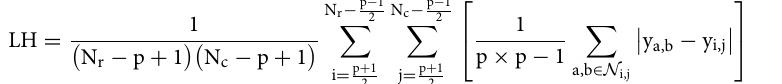
where y i , j is the intensity of the pixel in the i th row and j th column of an image (denoted by Y ), and N i , j is a p × p neighborhood centered around y i , j but not including y i , j . In a p × p neighborhood, the average abso- lute difference between the center pixel and the neighbor pixels is calculated to measure the neighborhood heterogeneity. The LH measure is the mean neighborhood heterogeneity obtained by moving the neighbor- hood window across the whole image. The LH measurements were calculated with multiple neighborhood sizes for both IGTD and REFINED image representations. Two-tail pairwise t-test 27 was applied across CCLs or drugs to examine the LH difference between IGTD and REFINED images. For each CCL and drug, we also calculated the percentage that IGTD reduced the local heterogeneity compared with REFINED, which is ( LH REFINED − LH IGTD )/ LH REFINED × 100% , where LH REFINED and LH IGTD are the LH measurements of the REFINED and IGTD images, respectively. Table 1 shows the result. For both CCLs and drugs and all neighbor- hood sizes in consideration (i.e. 3, 5, 7, and 9), the average LH of the IGTD images is always statistically signifi- cantly lower (p-values ≤ 0.05) than that of the REFINED images. This result indicates that the IGTD algorithm better preserves the neighborhood structure of features in the 2-D images, so that similar features are grouped closer in IGTD images. We also compared the runtimes of IGTD, REFINED, and DeepInsight for converting tabular data into images. For the gene expressions of CCLs, IGTD, REFINED, and DeepInsight took 0.66, 7.69, and 0.04 hour to convert them into images, respectively. For the drug descriptors, IGTD, REFINED, and DeepInsight took 0.74, 5.13, and 0.07 h to convert them into images, respectively. Notice that both IGTD and DeepInsight were executed with one CPU processor, while REFINED was executed with parallel computing using 40 processors of the same specification. This result indicates that DeepInsight converts tabular data into images significantly faster. This observation is expected, because DeepInsight does not generate compact image representations that require an optimization process to assign features to suitable pixel positions as what IGTD and REFINED do. Interestingly, for the two methods that generate compact image representations, the runtimes of REFINED were much longer than those of IGTD, even when REFINED used parallel computing with 40 processors while IGTD used only a single processor. Drug response prediction using CNNs based on image representations. We performed drug response prediction using CNN models trained on the IGTD image representations. See Section 2 in the Supple- mentary Information for the preprocessing of drug screening datasets. The area under the dose response curve (AUC) was taken as the prediction target in a regression setting. Fig. 3 shows the architecture of the CNN model. For both CCLs and drugs, a subnetwork of three convolution layers, each of which has 5 × 5 kernels and sub- sequent batch normalization, ReLU activation, and maximum pooling layers, accepts the image representations as the input. The output feature maps from the subnetworks are flattened, concatenated, and passed to a fully connected network to make predictions. The total number of trainable parameters in the model is 1,307,218. The mean square error was used as the loss function to be minimized during model training. A tenfold cross- validation was performed to train and evaluate the prediction models, in which eight data folds were used for model training, one data fold was used for validation to select the dropout rate and for early stopping to avoid